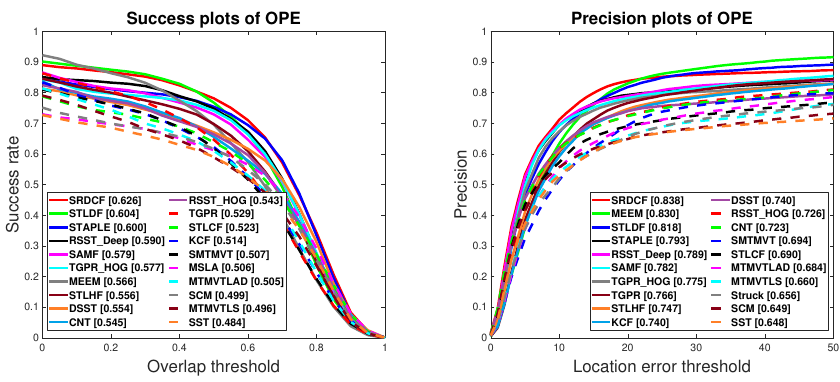
Figure 2. The overall one pass evaluation (OPE) plots for 50 frame sequences in